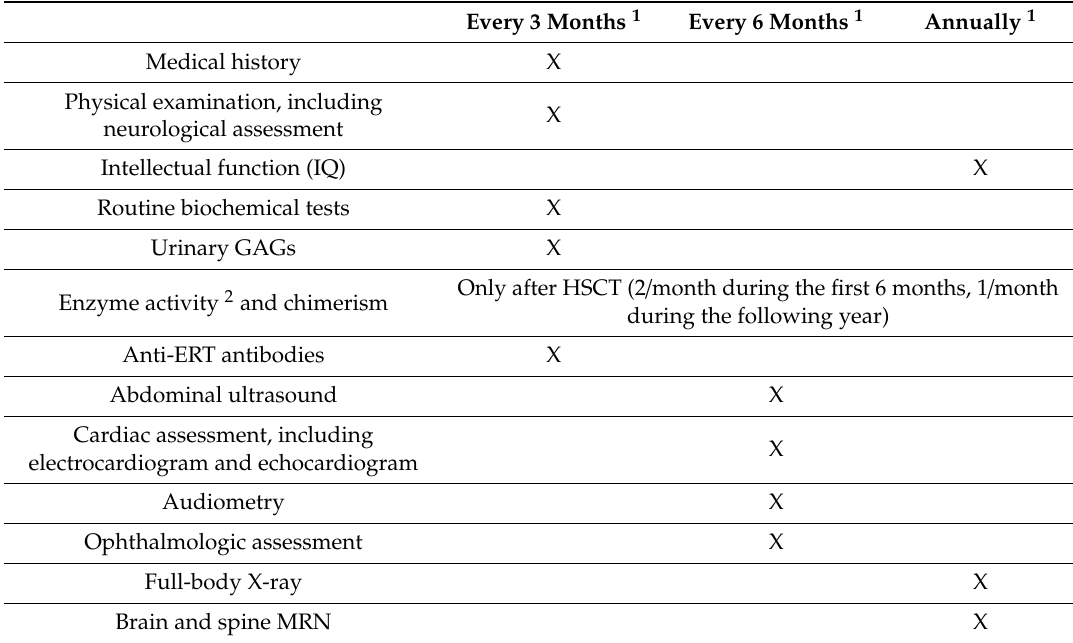
Table 2. Clinical follow-up of patients with confirmed MPS